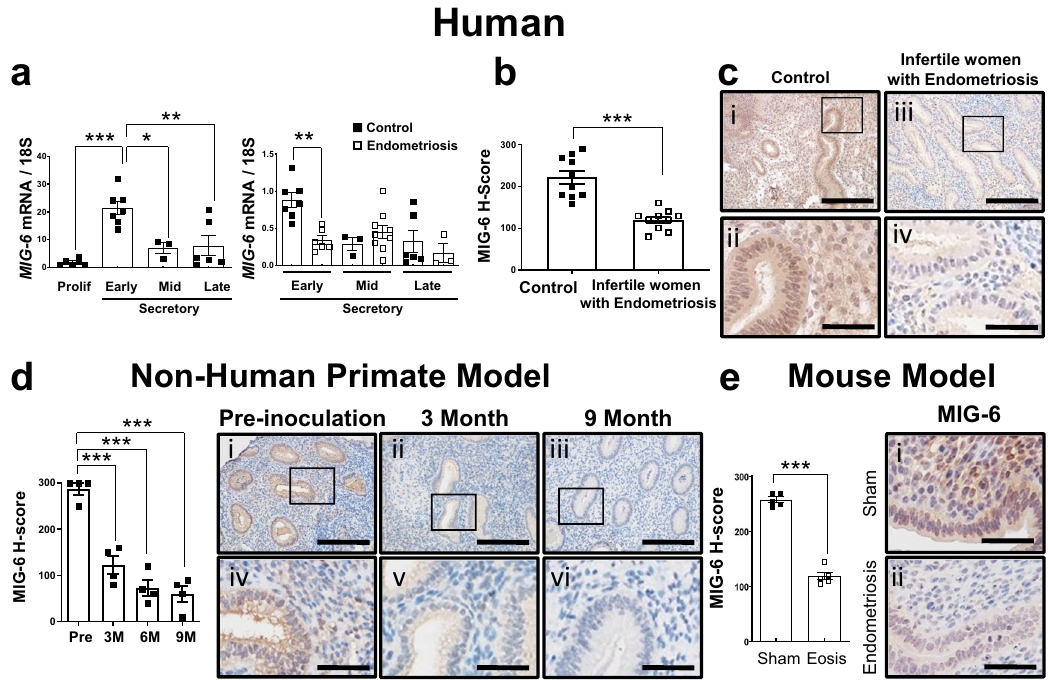
Fig. 1 MIG-6 expression in the endometrium of women with endometriosis and nonhuman primate, baboon model. a RT-qPCR analysis of MIG-6 gene expression in endometrium from women with and without endometriosis during the menstrual cycle ( n = 6 for proliferative, n = 7 for early secretory, n = 3 for mid secretory, and n = 6 for late secretory without endometriosis and n = 6 for early secretory, n = 9 for mid secretory, and n = 3 for late secretory with endometriosis). Filled square boxes represent endometrial samples from women without endometriosis, and empty square boxes represent